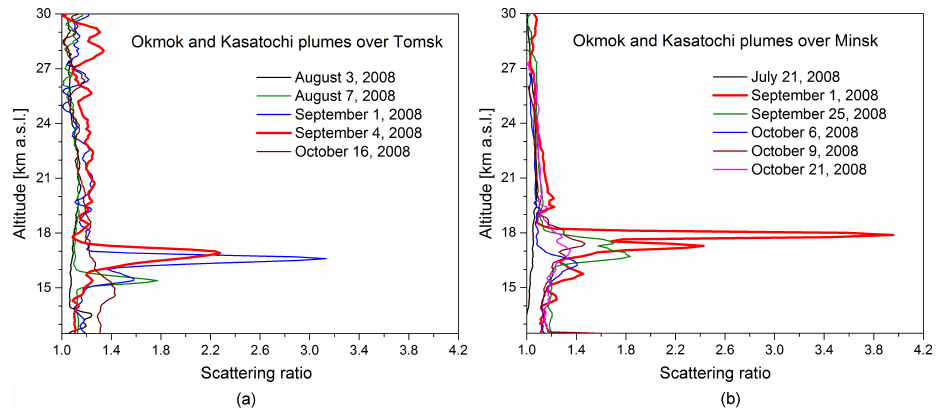
Figure 5. Detection of the Okmok and Kasatochi volcanic plumes in the stratosphere over (a) Tomsk (Russia) and (b) Minsk (Belarus). The volcanoes started to erupt in the Aleutian Islands on 12 July and 7 August 2008,